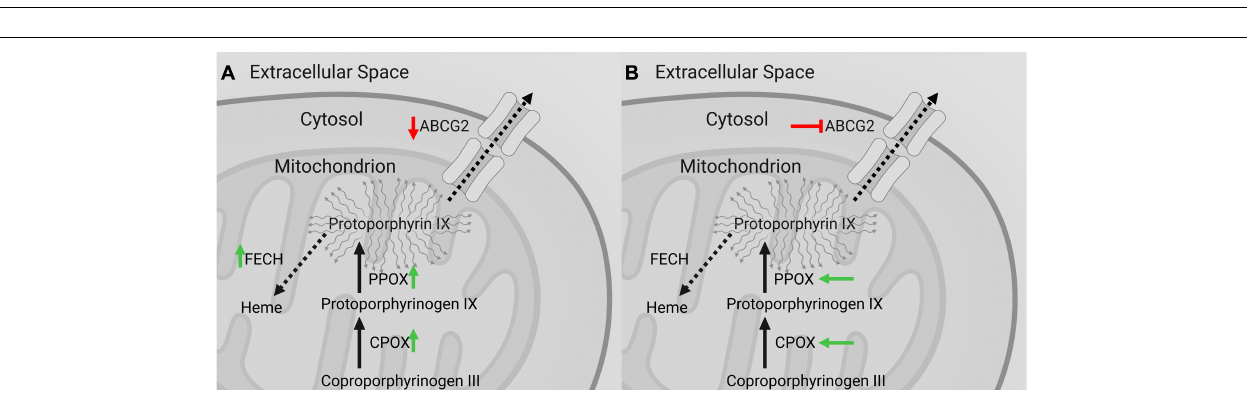
FIGURE 5 | Case illustration of a typical patient from the non-fluorescing group. The images are obtained from the case of a 50-year-old female patient that underwent 5-ALA fluorescence-guided resection of a suspected low-grade glioma. In the first row, preoperative imaging including T1-weighted images before (A) and after (B) contrast-medium application as well as a T2-weighted image (C) and a 11 C-methionine PET image (D) are shown. In the second row, the intraoperative situs is shown under conventional white light (E) and violet-blue excitation light (F) as well as routine histopathological analysis including H&E staining (G) and IDH mutation immunohistochemistry (H) . In the third row, study specific immunohistochemical stainings are shown including CPOX (I) , PPOX (J) , FECH (K) , and ABCG2 (L) .